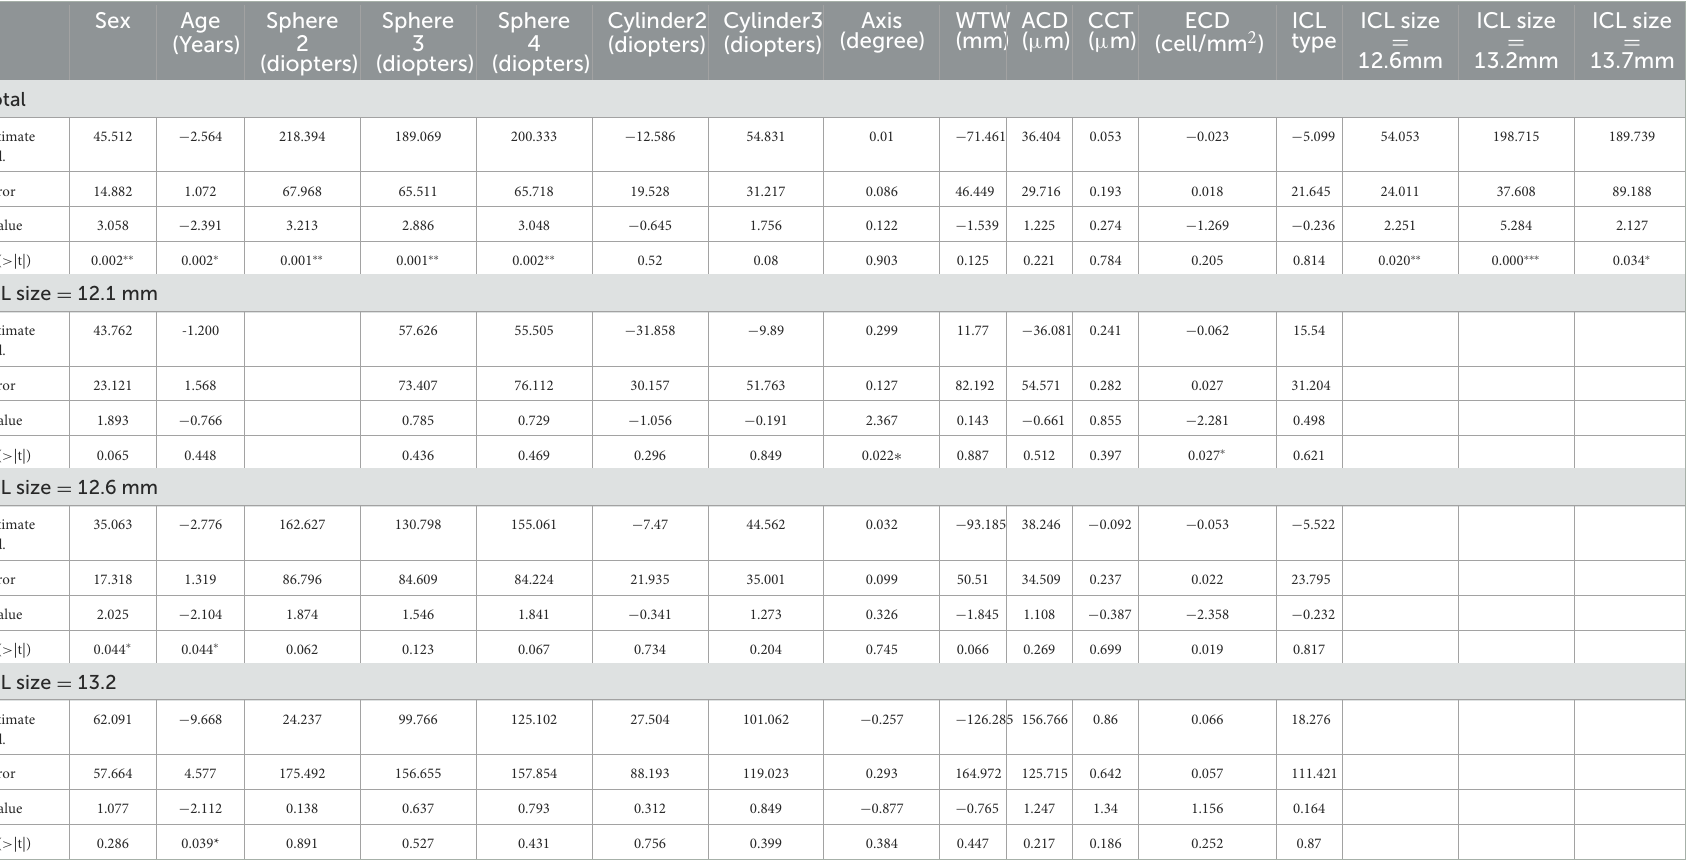
TABLE 2 Coefficient measures of each of the parameters and the achieved vault